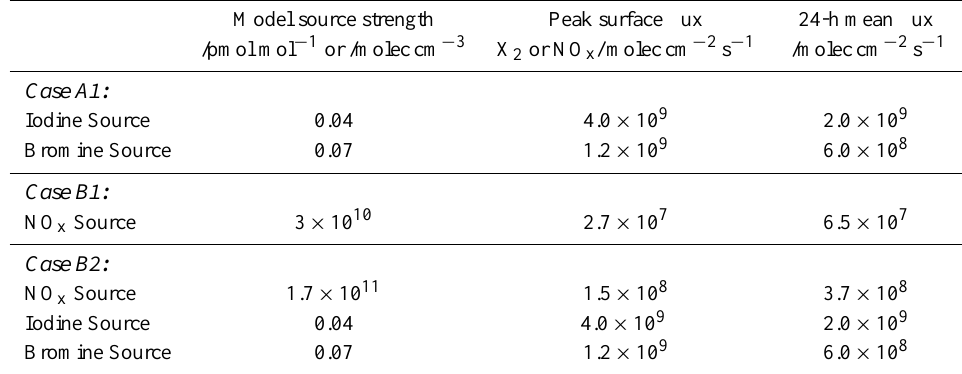
Table 2. NO x and halogen source strengths, and corresponding surface fluxes, incorporated in model simulations.